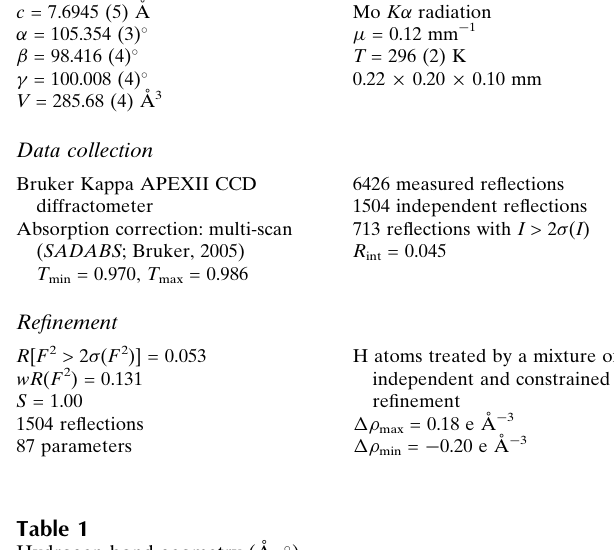
Hydrogen-bond geometry (A˚ , (cid:2)